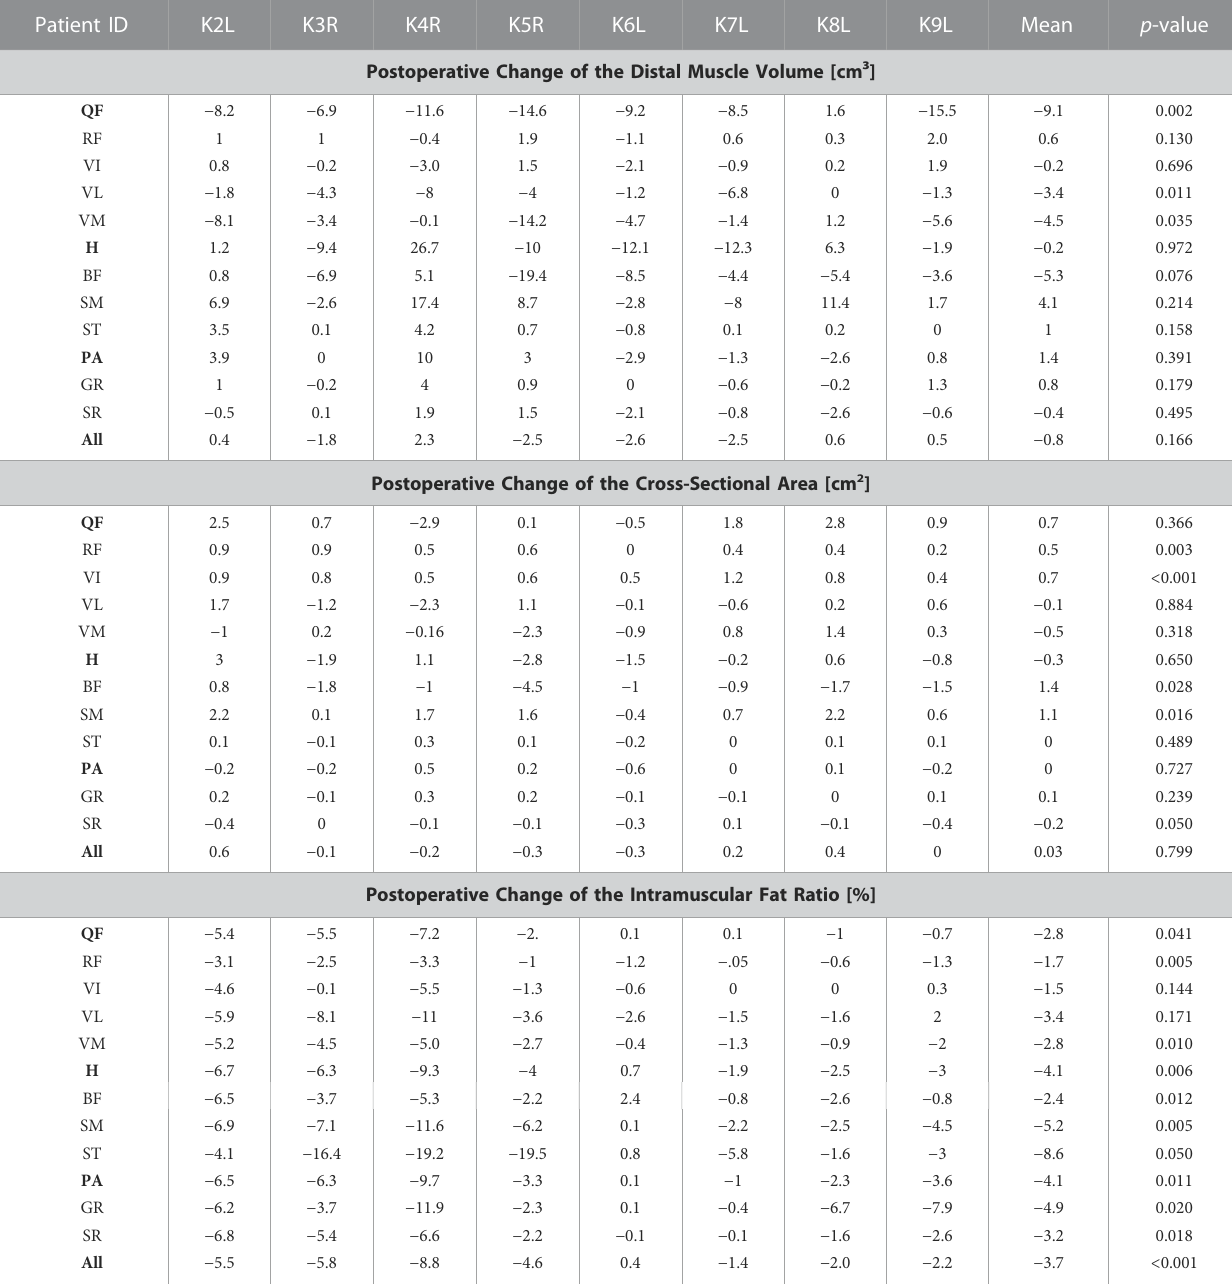
TABLE 2 Postoperative change of the distal muscle volume, the cross sectional area and the intramuscular fat ratio, QF – Quadriceps Femoris, RF – Rectus Femoris, VI – Vastus Intermedius, VL Vastus Lateralis, VM – Vastus Medialis, H – Hamstrings, BF – Biceps Femoris, SM – Semimembranosus, ST – Semitendinosus, PA — Pes Anserinus group, GR – Gracilis, SR – Sartorius. Patient